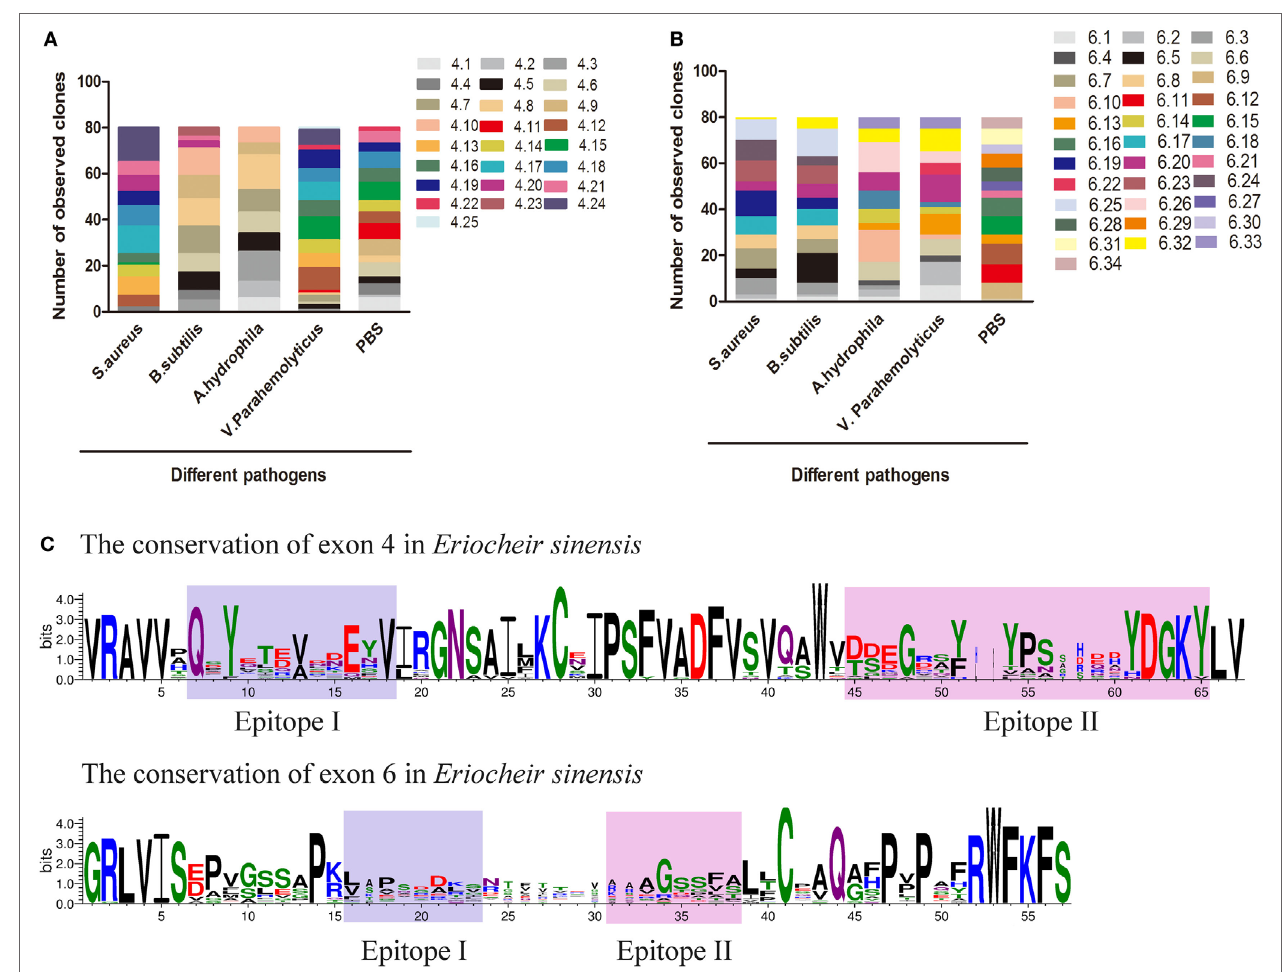
FigUre 3 | Preferential variants of exon 4 and exon 6 after bacterial stimulation in hemocyte. (a) Number of observed clones of exon 4 in hemocytes post- challenged with various bacteria and PBS (control). The variants of exon 4 were analyzed by cloning and sequencing 80 clones from each group. Individual colonies were randomly selected from each sample. All assays were repeated on two independent occasions, and values represent the mean number of observed clones from two independent experiments. The serial number of exon 4/6 was assigned and the amino-acid sequences of exon 4/6 are shown in Figure S3 in Supplementary Material. (B) Number of observed clones of exon 6 post-challenge with various bacteria and PBS. (c) Differential sequence conservation of epitopes I and II of Es Dscam following alternative splicing of exon 4 and exon 6. ( Upper panel ) Sequence logo representation of the conservation of exon 4 variants in Eriocheir sinensis ; ( lower panel ) sequence logo representation of the conservation of exon 6 variants in E. sinensis . Bits ( y -axis) indicate units of evolutionary